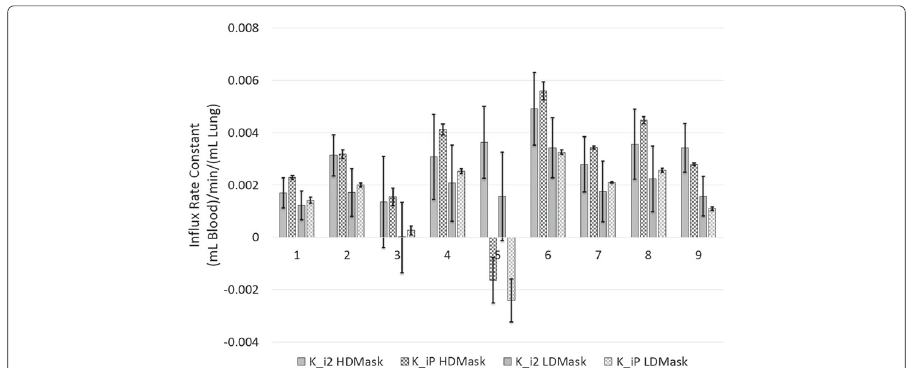
Theoretically, the two methods of calculating K i (compartment model and Patlak- Rutland analysis) should render the same results. However, the maximum percentage difference between the estimated K i parameters was found to be 250%. The average and standard deviation of the differences between the parameter estimates from the two anal- ysis methods for the derived TTACs in the high and low density regions are 51 ± 102% and 43 ± 54%